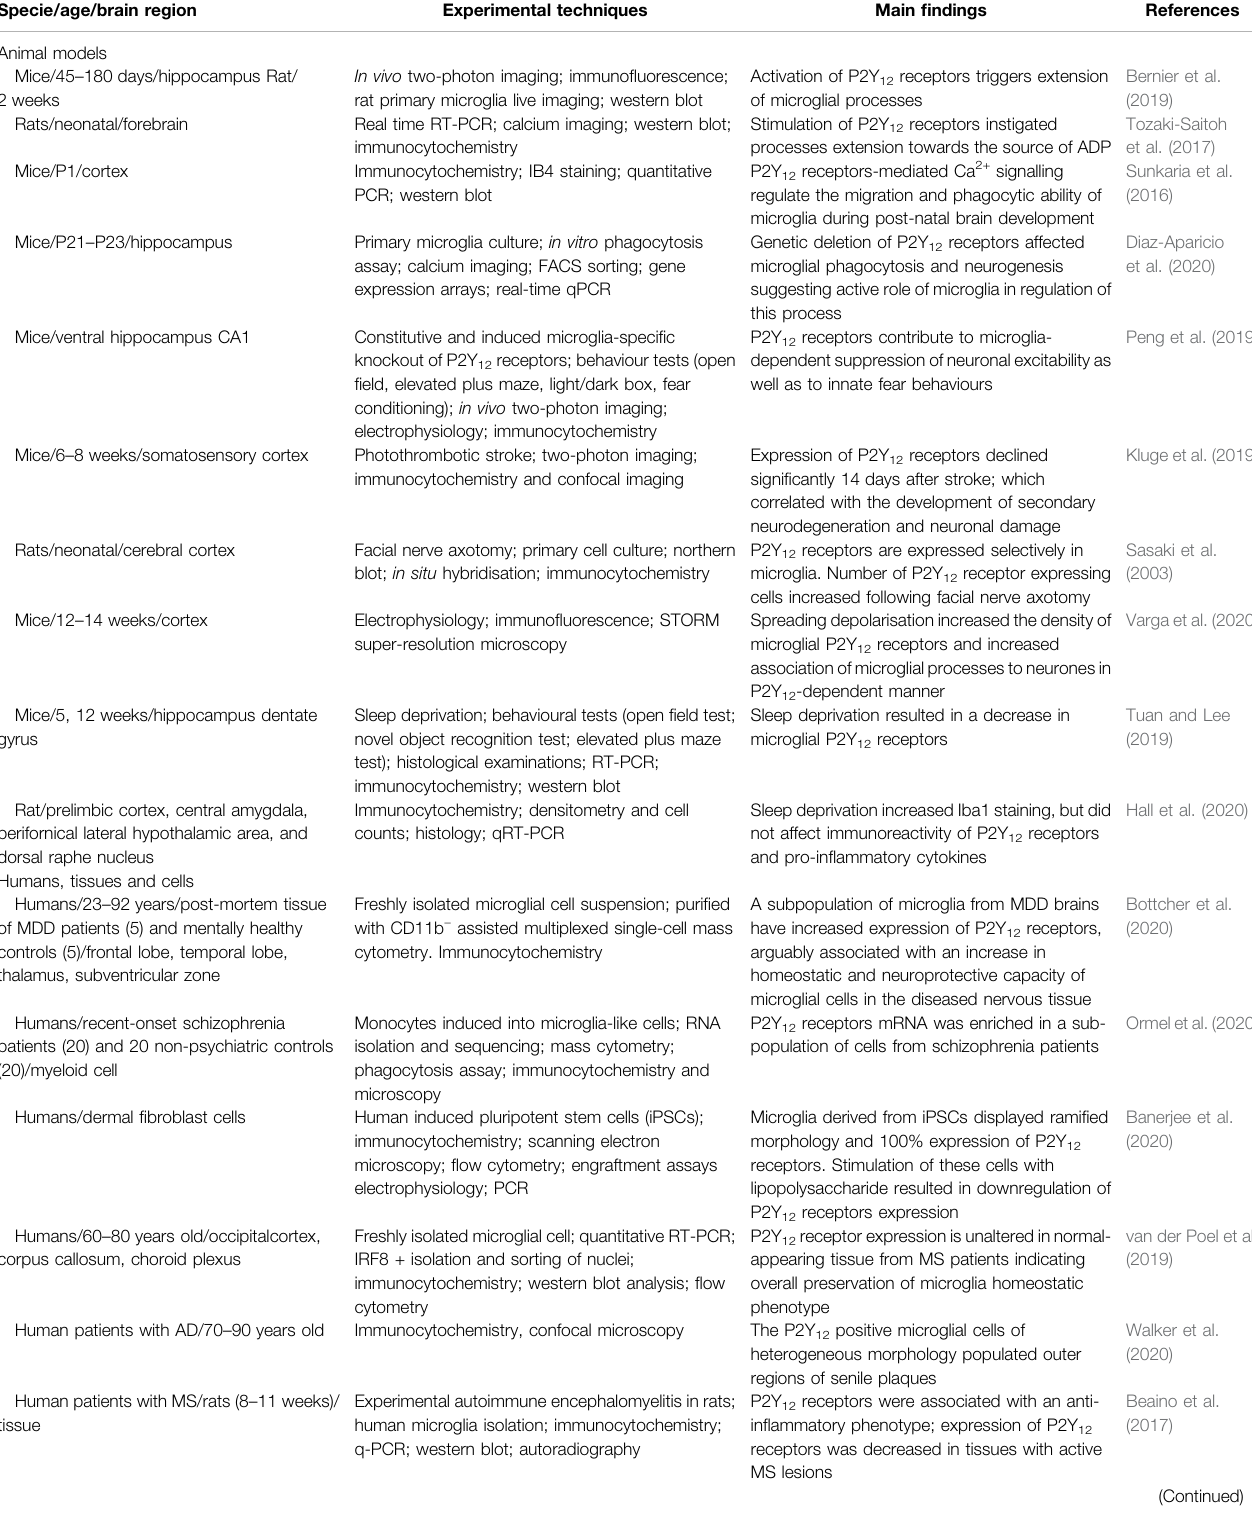
TABLE 1 | Microglial P2Y 12 receptors in healthy and diseased